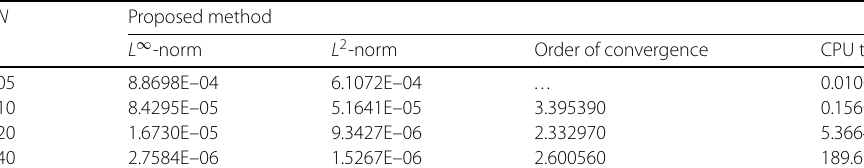
Table 7 Maximum absolute errors and Euclidean norm ( L 2 ) at T = 1 for Problem 2